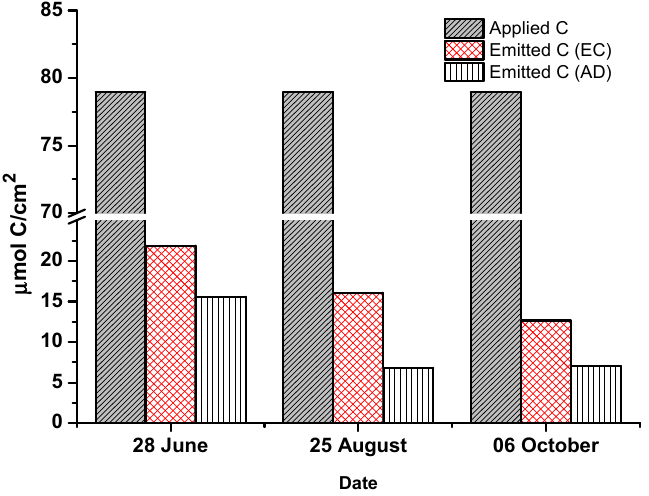
Figure 4. Estimated applied and net emitted C 24 h after effluent dose application at E. camaldulensis (EC) and A. donax (AD)